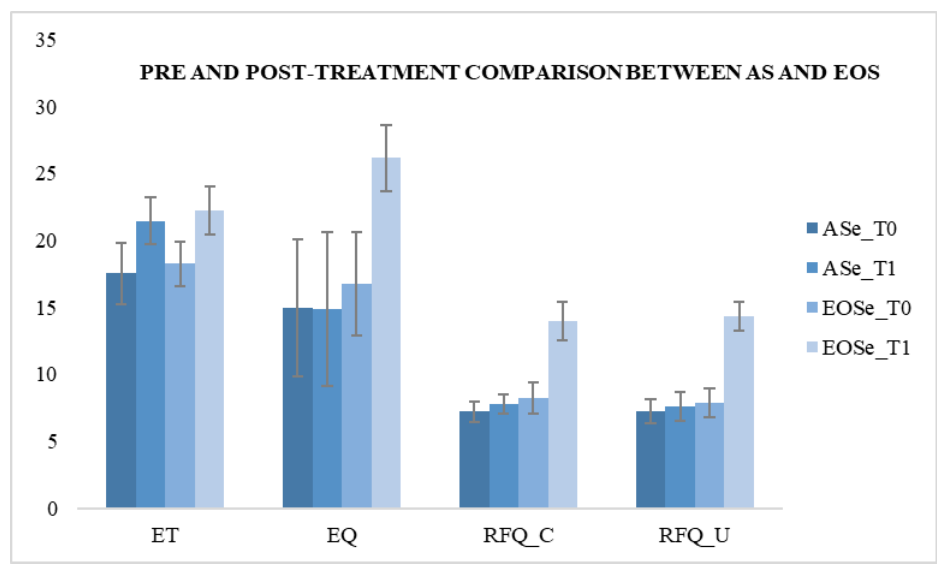
Figure 1. Comparison between autism spectrum group ASe and early onset schizophrenia group EOSe at T0 and T1.